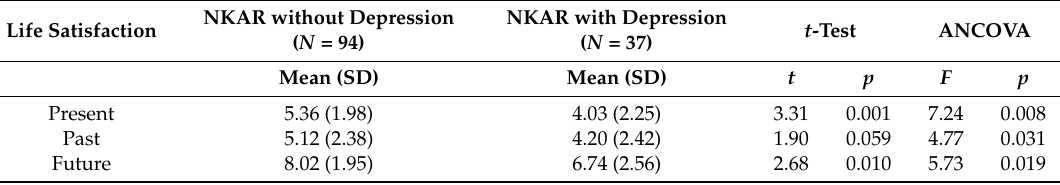
Table 3. Perceived quality of life of North Korean adolescent refugees (NKAR) with and without depression.